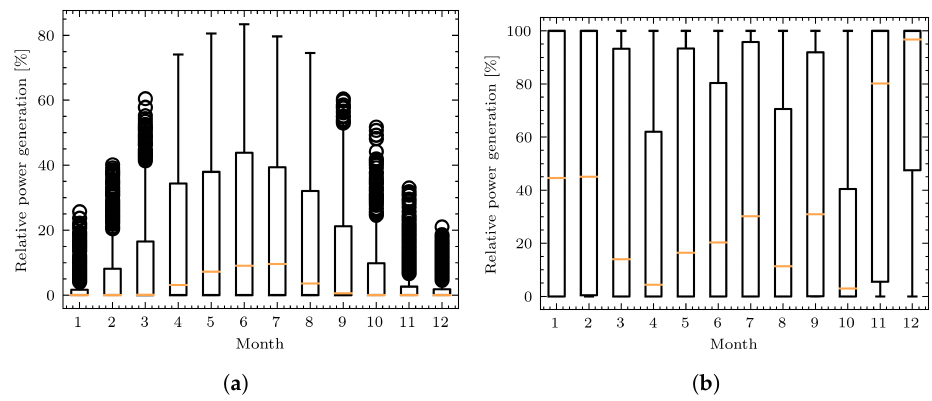
Figure 10. ( a ) Relative PV power generation in relation to installed generation capacity. ( b ) Relative wind power generation in relation to installed generation